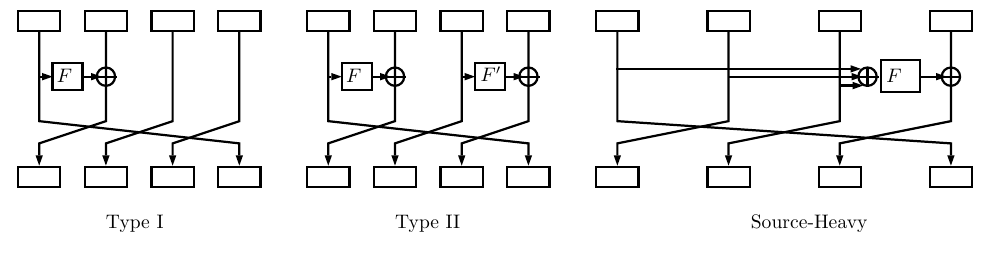
Figure 10: One round of the Feistel construction of type I, type II and source-heavy for variants with 4